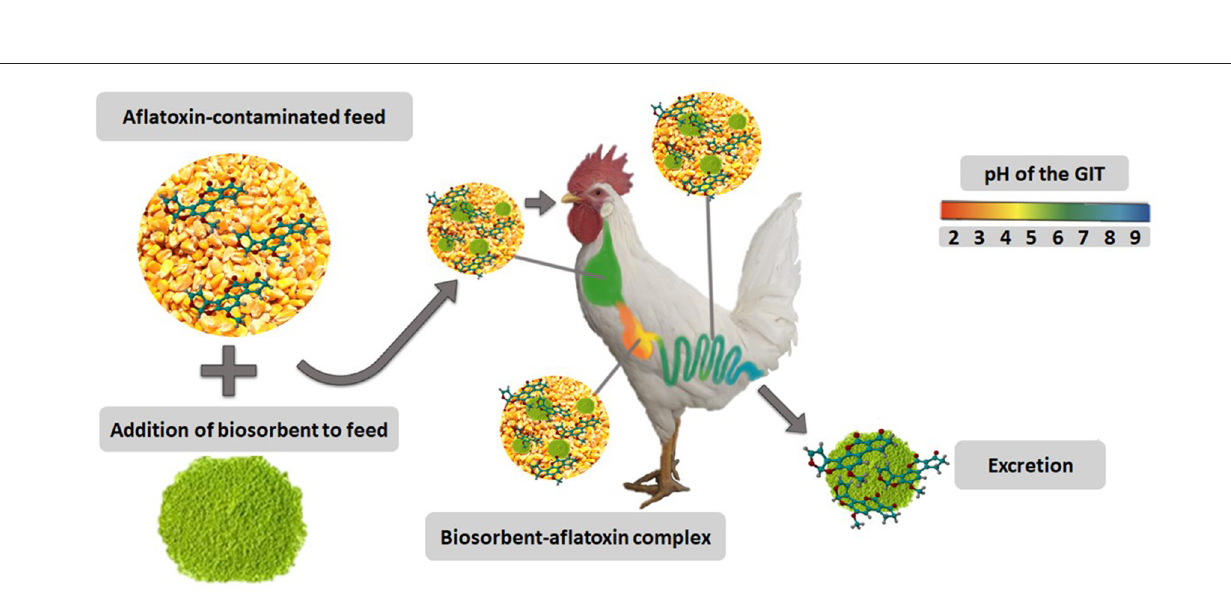
Frontiers in Veterinary Science |